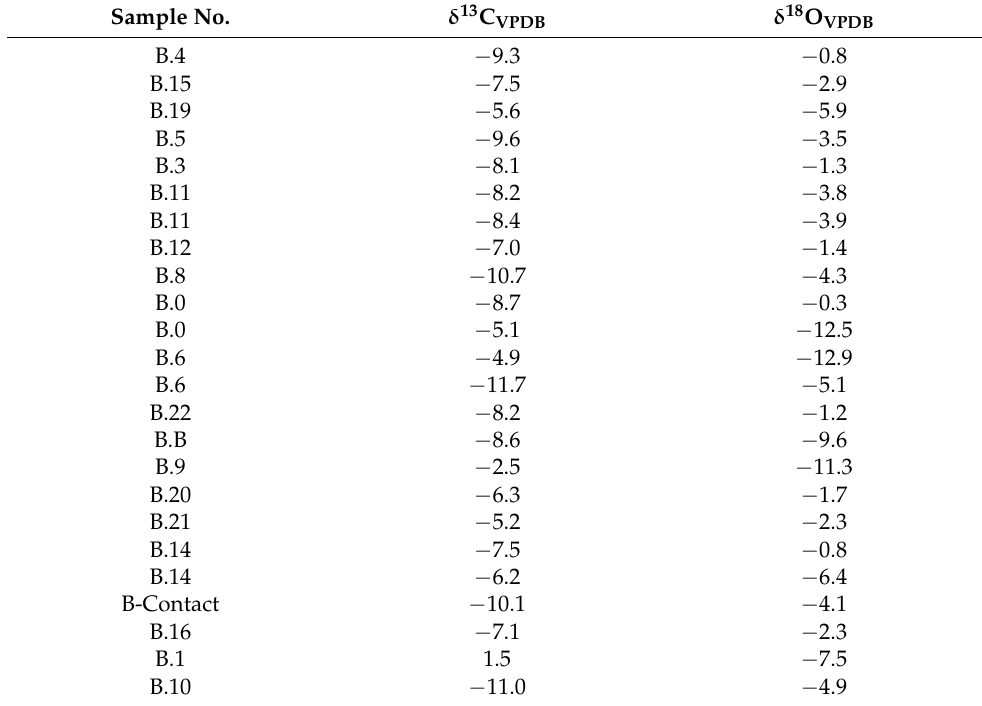
Table 1. δ 13 C (% VPDB), δ 18 O (% VPDB) values of selected samples from Barsarin formation (n = 24). Sample No. δ 13 C